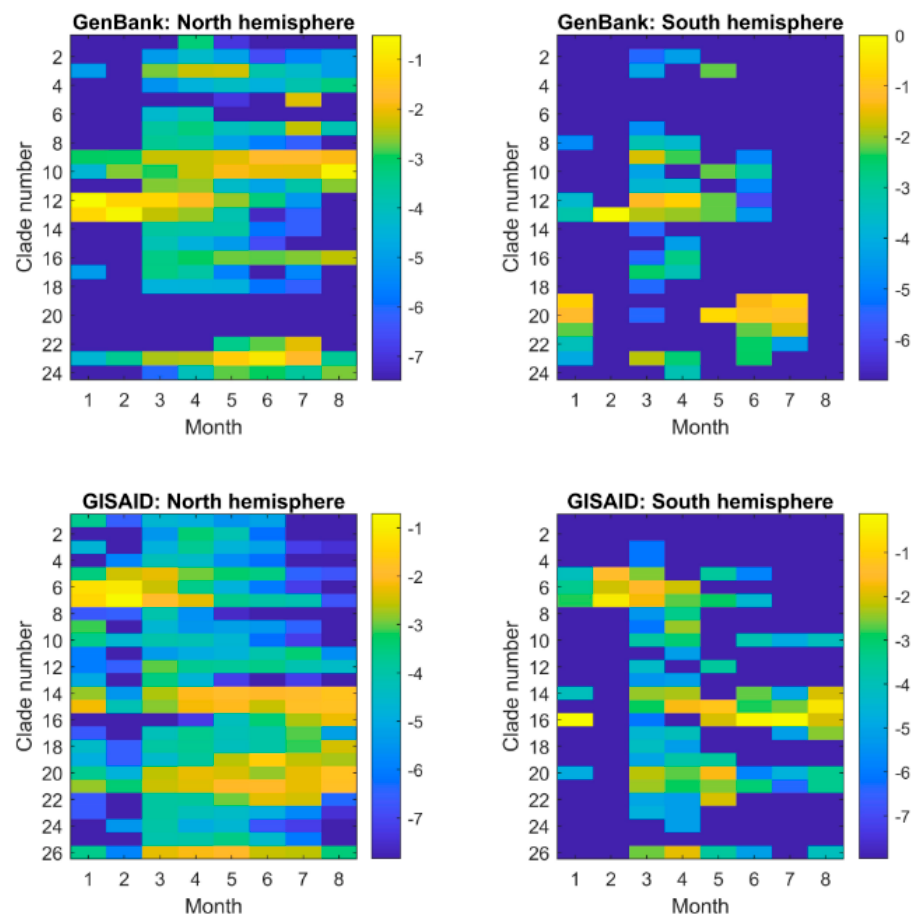
Figure 4. Similarity pattern of SARS − CoV − 2 sequences collected in different periods of time (x-axis) in GenBank (the top panel) and GISAID (the bottom panel) from the countries in the north hemisphere (the left panel) and south hemisphere (the right panel). The fractions of the sequences collected in a month in the major clades were represented by the logarithmic values of the numbers of sequences in major clades divided by total number of sequences collected in the month and depicted by the color legend at the right side. No sequence was in the major clades from the countries in the south hemisphere for August in GenBank, and thus the minimum was used to represent the corresponding logarithmic values.